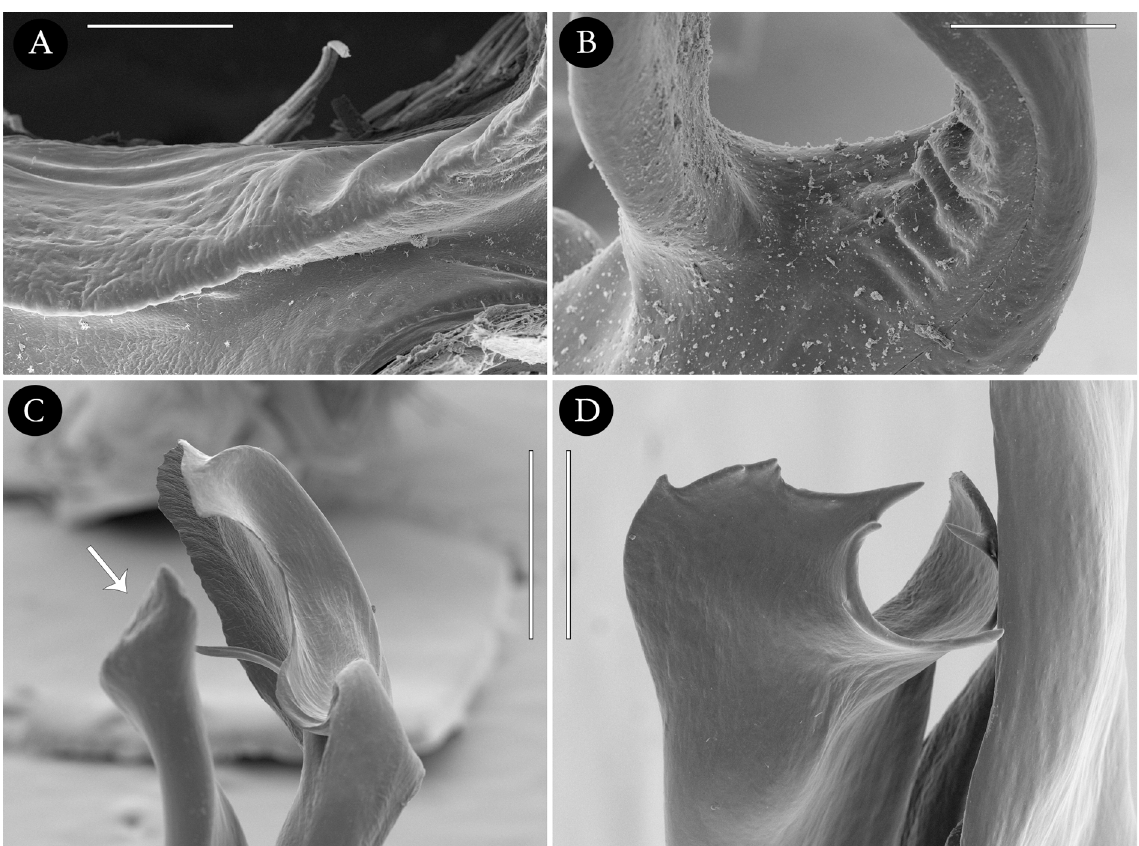
Fig. 6. A . Folds on the gonopod aperture in Atlantodesmus pintoi (Schubart, 1946). B . Folds on dorsal edge of the prefemoral region in A. pintoi . C . Smooth-edged prefemoral process in A. itapurensis (Schubart, 1943). D . Serrated prefemoral process in A. teresa (Hoffman, 2000). Scale bars: A–B = 2 mm; C = 500 µm; D = 200